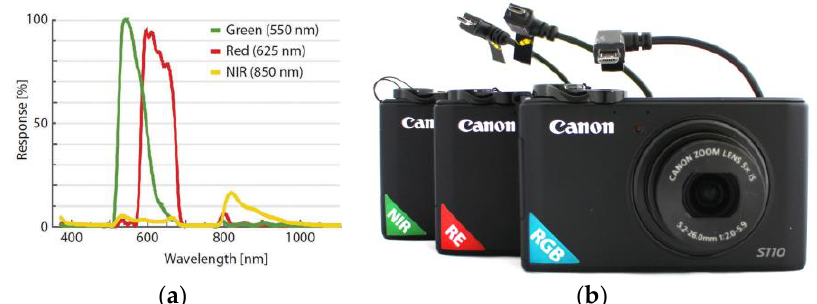
Figure 6. ( a ) Spectral response of the Canon PowerShot ELPH 110 HS (NIR) and ( b ) the changeable cameras for the eBee drone: near-infrared (NIR), red-edge (RE), and red-green-blue (RGB). The cam- era has a 1/1.7″ back-illuminated CMOS (Complementary metal–oxide–semiconductor) sensor, im- age size 12.1 MPix, camera weight 153g excl. battery.